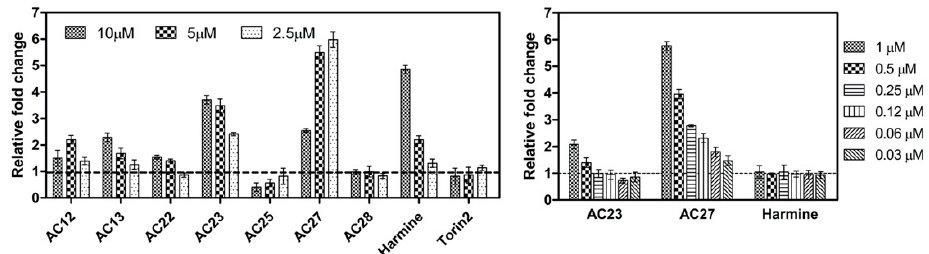
Figure 3. Effect on NFAT activity (luciferase reporter assay). Results are normalized at the basal activity of the luciferase (mock treated cells; CTRL). Application of 1 µ M of AC27 leads to the same activity as 10 µ M of harmine, making the former nearly 10 times more active in this particular cellular assay. Data are expressed as mean ± SD from 3 independent experiments.